Question: What does this figure show? Answer in one sentence.
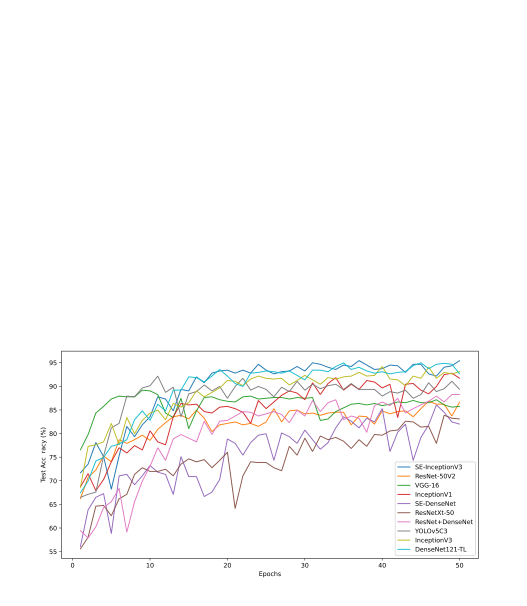
Answer: Comparison of accuracy of each model on